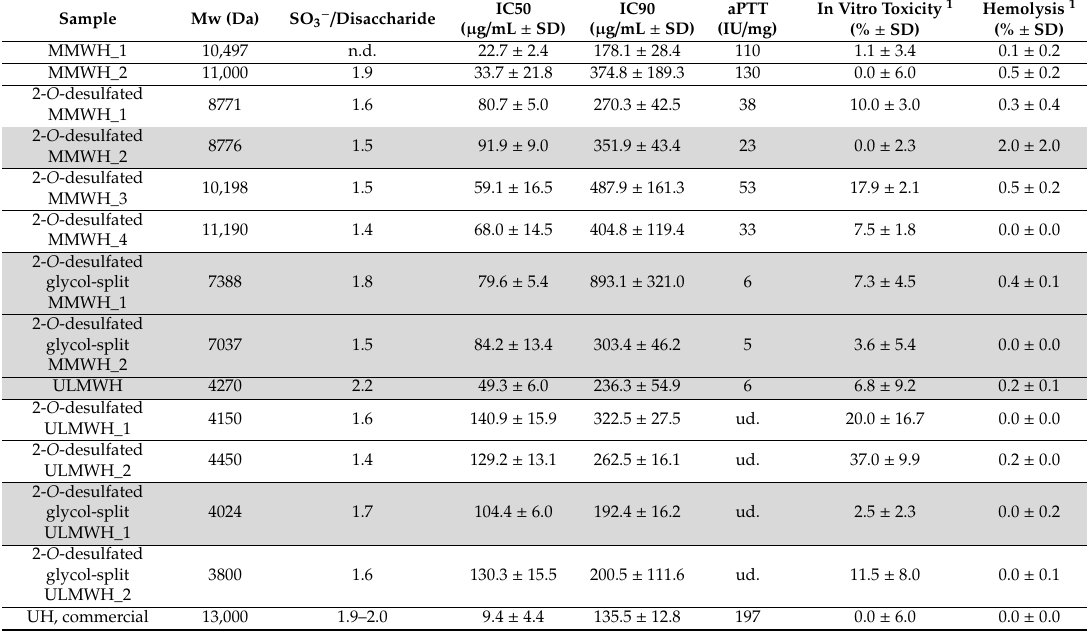
Table 2. Characterization of heparin samples that combine different chemical modifications. Shadowed in gray are the formulations selected for in vivo assays.